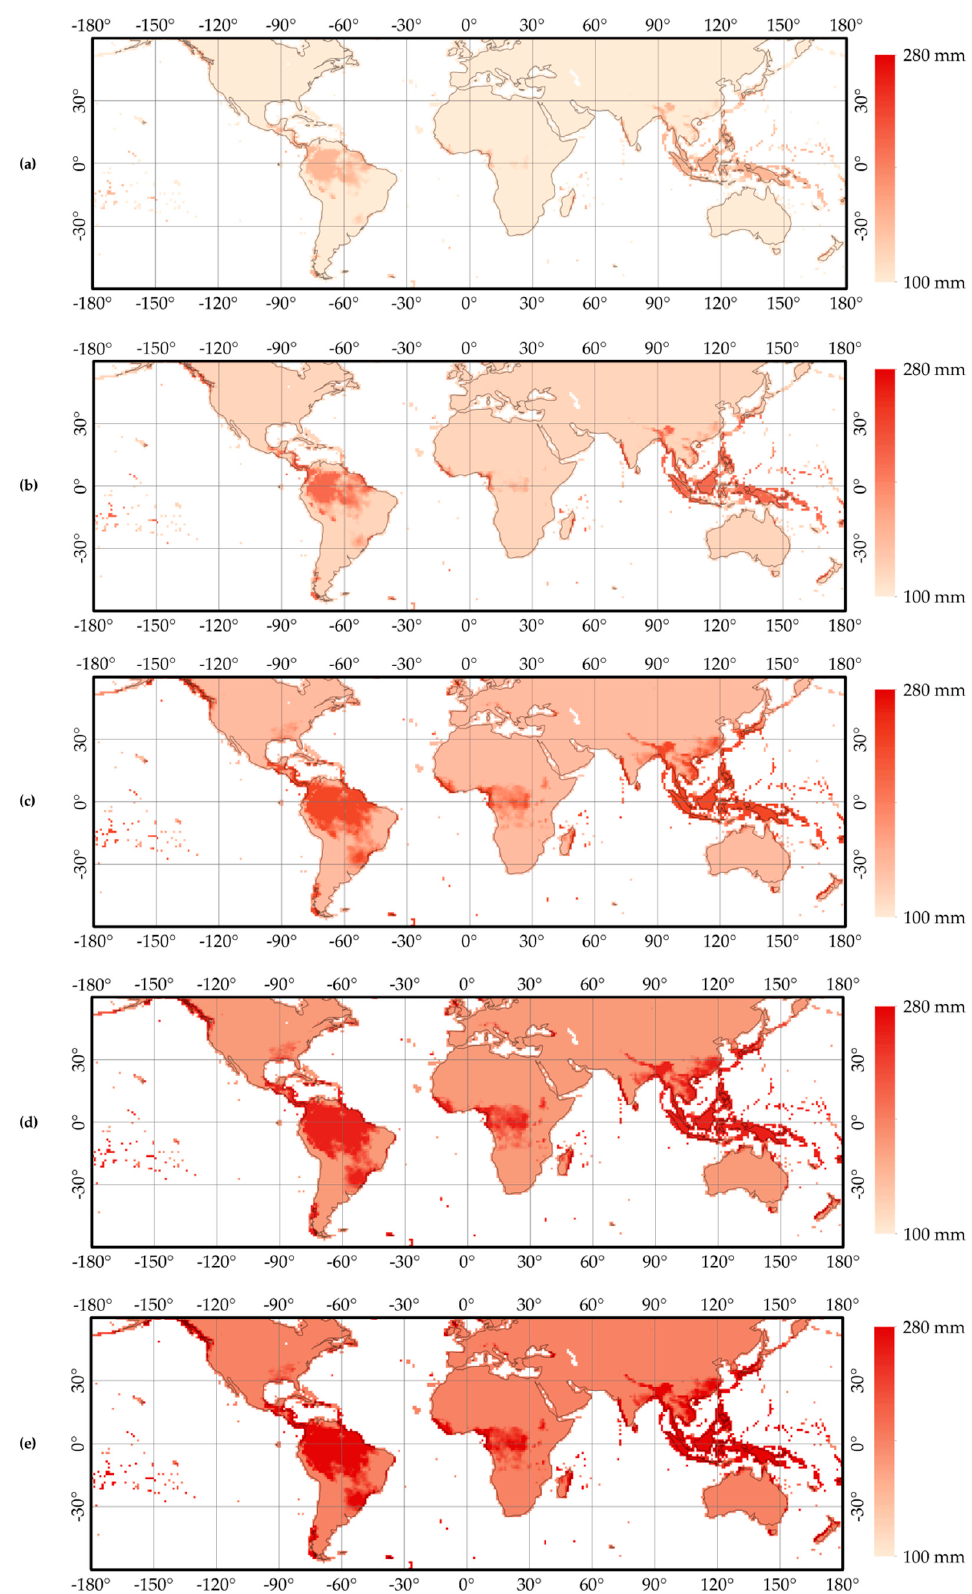
Figure A7. The event-identification threshold used for the extreme rainfall detection: The images are related to the 12 ( a ), 24 ( b ), 48 ( c ), 72 ( d ) and 96 ( e ) hours aggregation intervals. The reference system is WGS84.